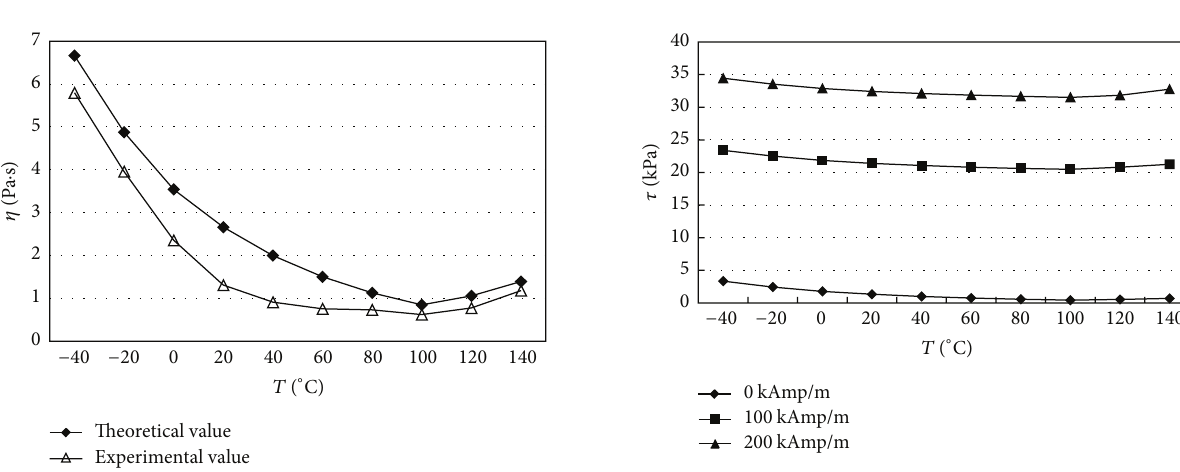
both attraction and internal friction decline; on that basis, the shear stress produced by shear deformation correspondingly decreases, and as a result, the viscosity declines. In addi- tion, this phenomenon is reversible under such temperature range. Once the temperature is higher than 100 ∘ C, the carrier fluid would be volatilized and the additives would be decomposed, which make the viscosity gradually increase. If the temperature is higher than 100 ∘ C, some additives may cause irreversible thickening of MR fluid after cycling under high and low temperature, which influences the chaining of the material in the applied magnetic field, resulting in the reduction of the shear stress and uncontrollability of the variation of the shear stress, the reduction of the transmission stability, and even the failure of transmission.